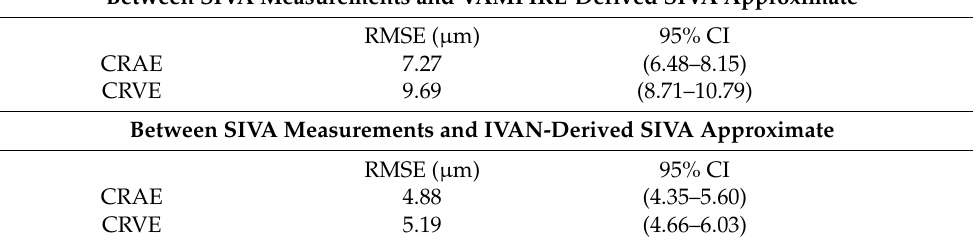
Table 4. Assessment of the robustness of the conversion algorithm using bootstrapping. The root- mean-square error between (RMSE) SIVA measurements and VAMPIRE-derived SIVA approximates or IVAN-derived SIVA approximates (RMSE in µ m) is included in the ICC interval obtained in 1000 bootstrap samples. AVR: arteriole-to-venule ratio, CRAE: central retinal artery equivalent, CRVE: central retinal vein